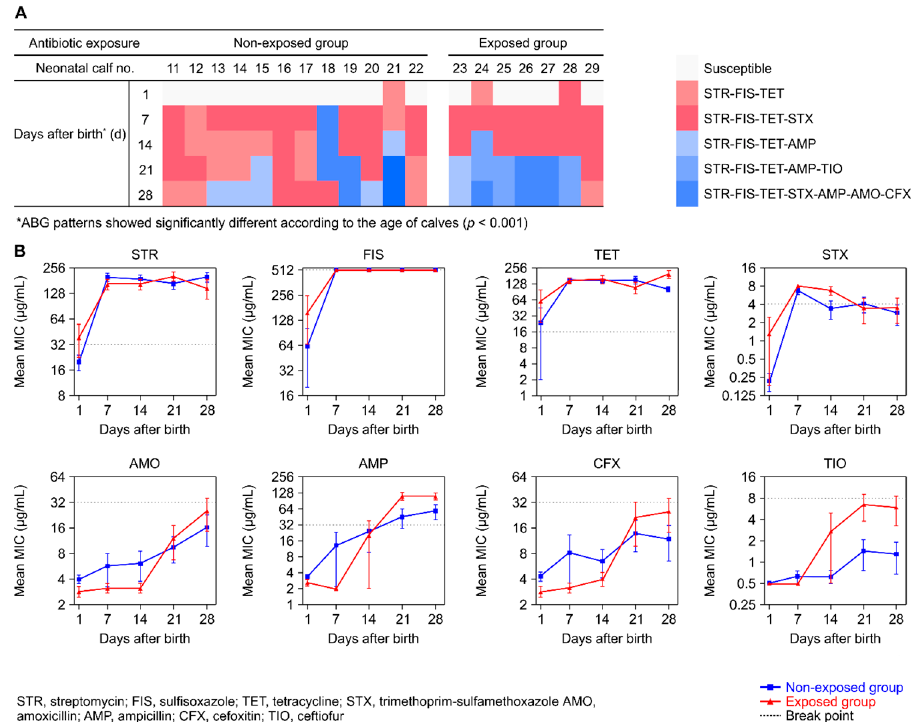
Figure 3. Characterization of resistance to eight antimicrobials in newborn dairy calves ( n = 19) from the first day after birth and at weekly intervals for up to 4 weeks. ( A ) Antibiogram (ABG) of fecal E. coli isolated from newborn calves. Each box represents a single isolate on a given sampling day. Colors represent ABG patterns, and unfilled boxes indicate that isolates were susceptible to all tested antimicrobials. ( B ) Changes in mean minimum inhibitory concentration (MIC) values according to calf age. Blue lines indicate the mean MIC in cases with no prior treatment with antibiotics in calves and their dams, and red lines indicate MIC values in cases of prior ceftiofur use in calves or their dams. Error bars represent standard error of the mean.